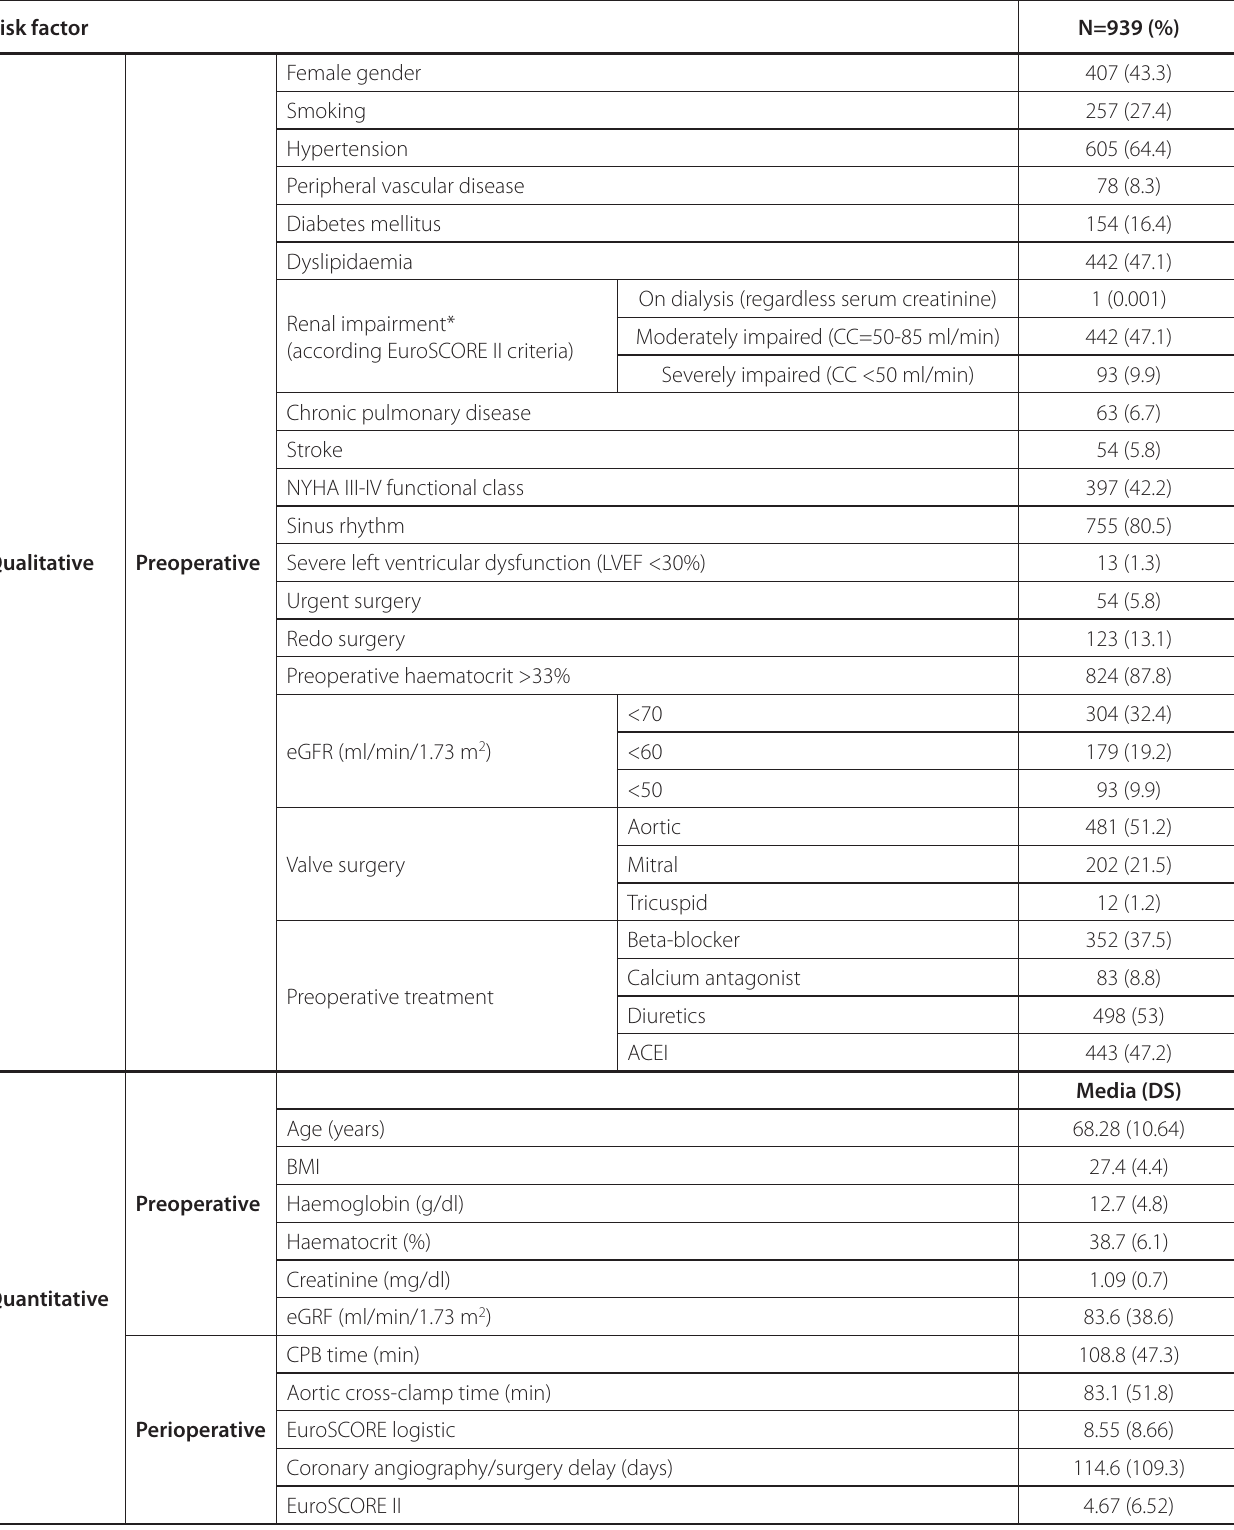
Table 1 . Preoperative characteristics of patients under heart valve surgery. Risk